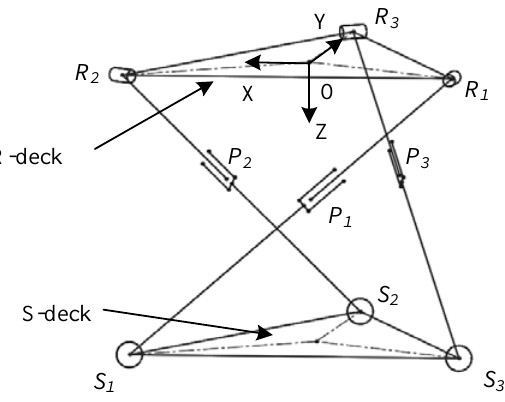
Figure 16. Structure demonstration of optimized compensation platform.